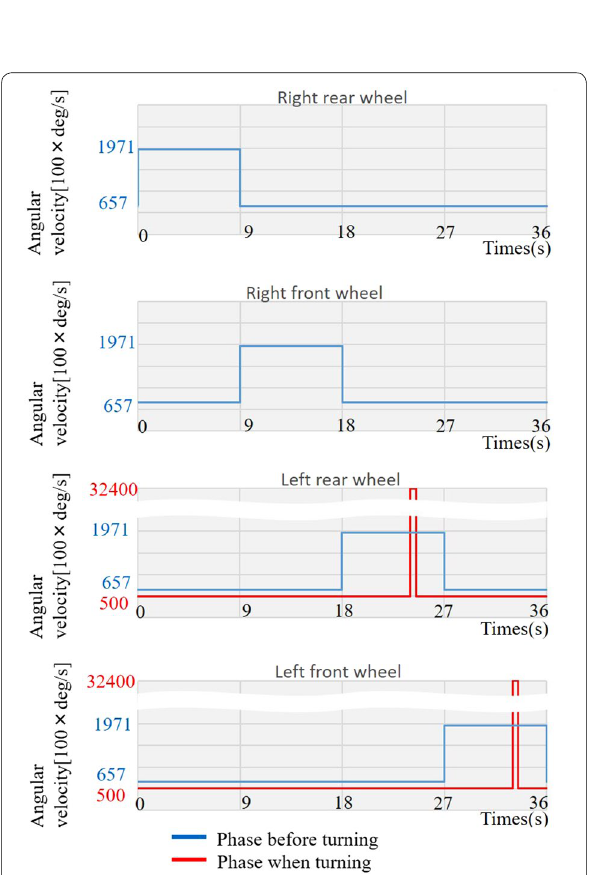
Fig. 15 Phase change of turning motion